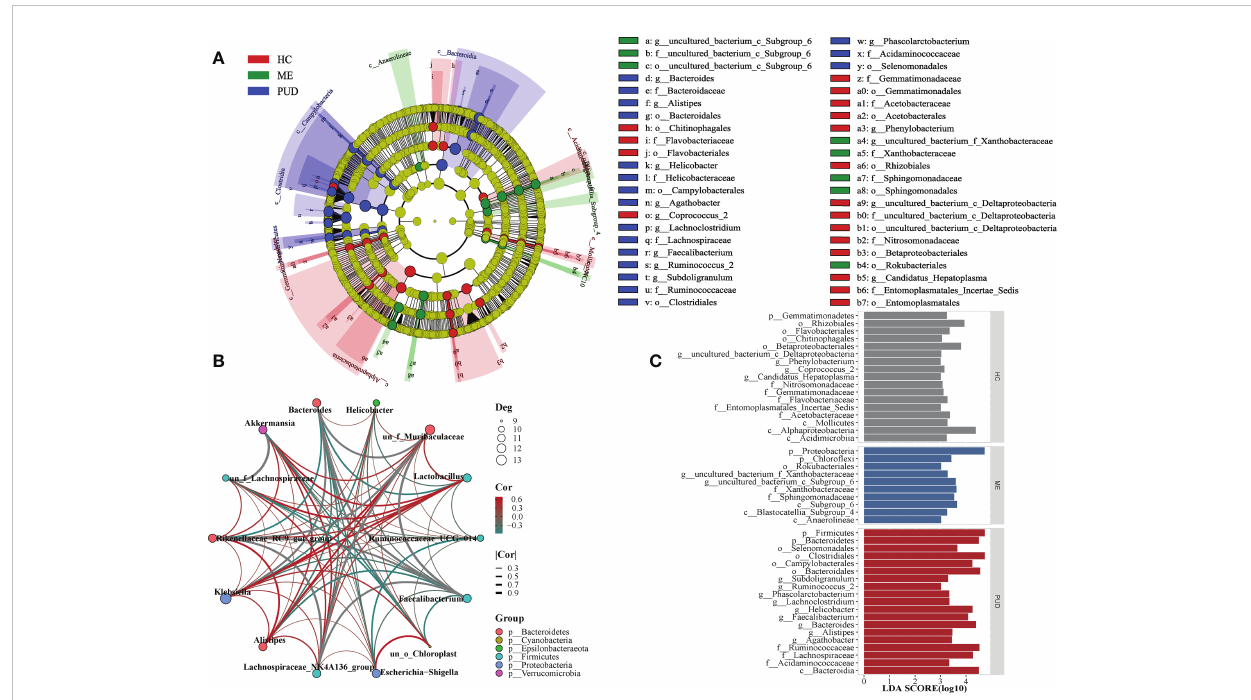
FIGURE 4 LEfSe and population correlation network. (A) , evolutionary tree diagram of LEfSe; (C) , histogram of LEfSe parameters; (B) , fl ora correlation network of PUD group. Deg indicates the number of connected nodes; Cor indicates correlation, and Group indicates the phylum to which the genus